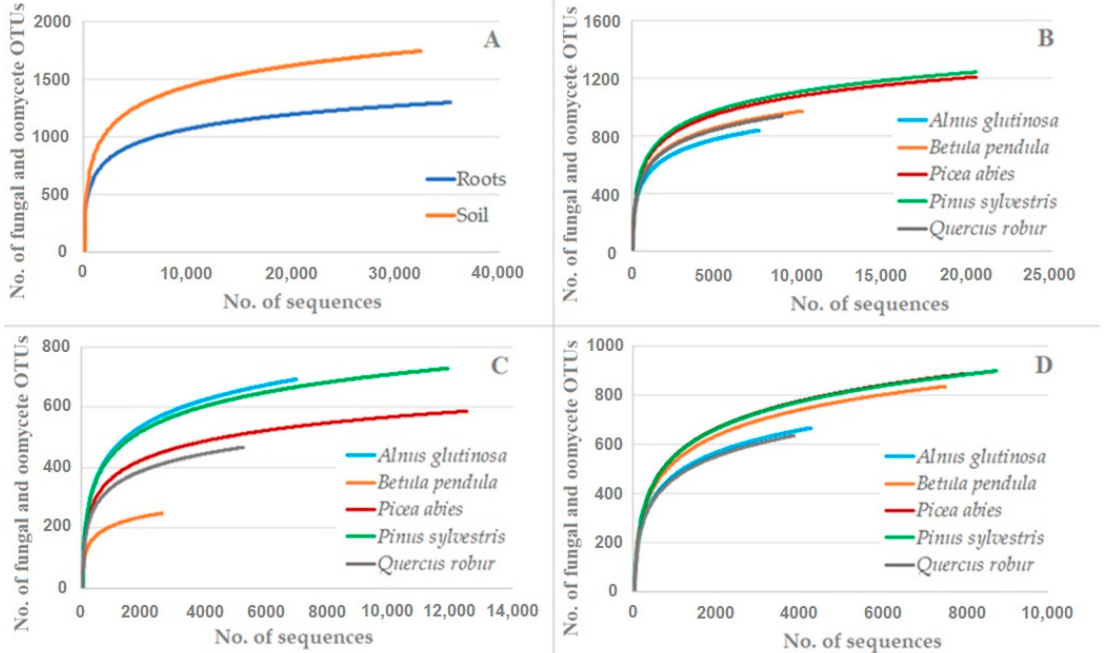
Figure 2. Rarefaction curves showing the relationship between the cumulative number of fungal and oomycete OTUs and the number of ITS rRNA sequences compared: ( A ) roots vs. soil; ( B ) the different tree species (roots and soil samples combined); ( C ) root samples of the different tree species; and ( D ) soil samples of the different tree species.